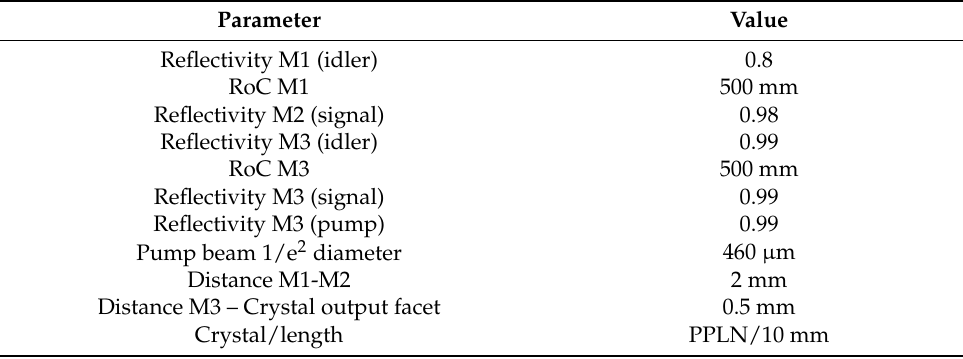
Table 2. Test NesCOPO parameters (RoC: Radius of